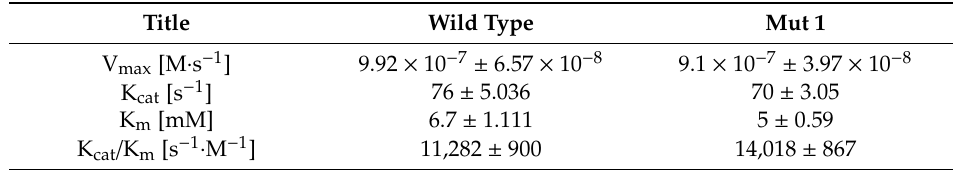
Table 1. Kinetic parameters of p NPG hydrolysis by wild-type C. thermocellum BglA and the thermostable mutant (Mut